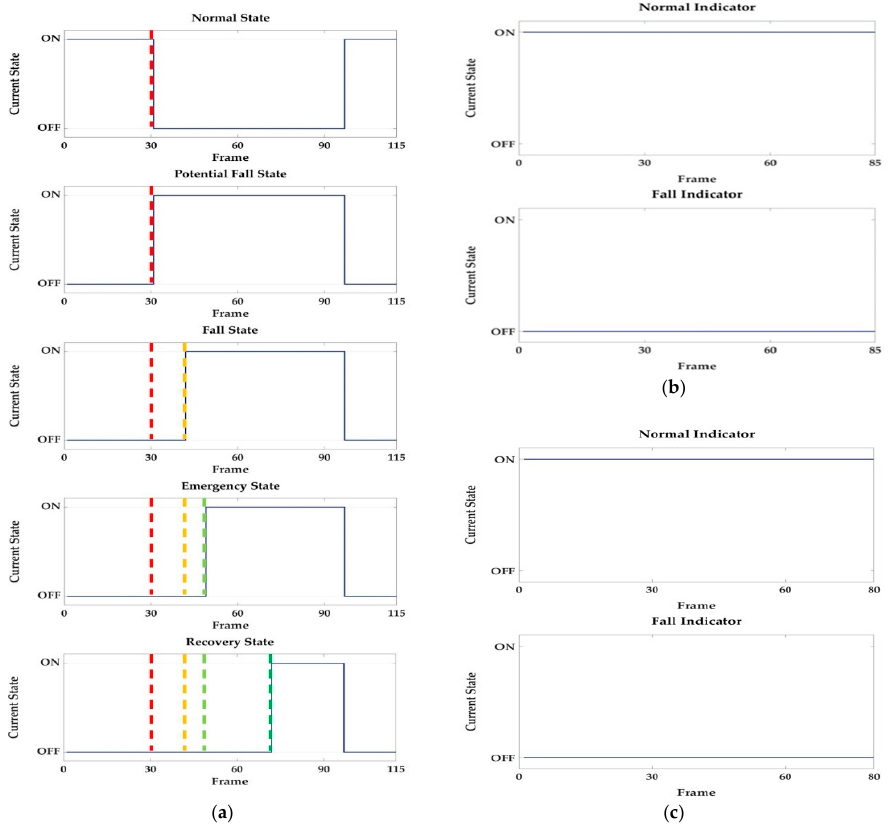
Figure 14. ( a ) Overall indicators for fall case; ( b ) Normal and Fall Indicator for sitting motion; ( c ) Normal and Fall indicators for squatting motion. ( b , c ) indicate normal cases. When the normal indicator is ‘ON’ and the fall indicator is 'OFF', it is interpreted as the 'Normal State' in case of sitting and squatting motion.